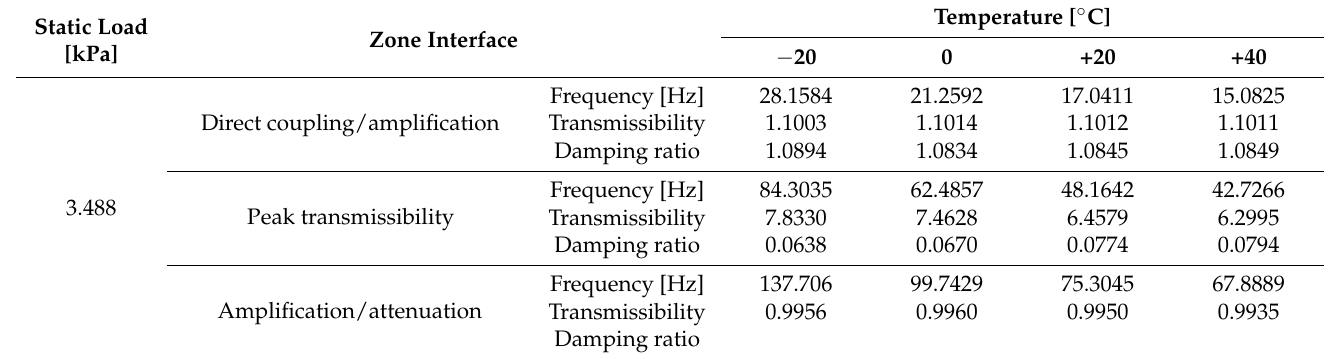
Table 3. Vibration transmissibility and damping ratio of PE30 cushion